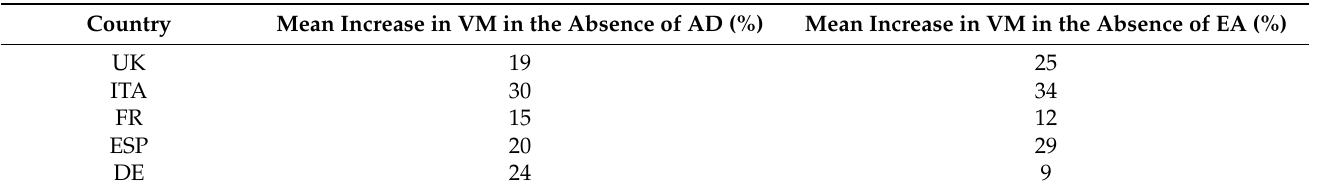
Table 2. Expert estimates of the absolute increase in A(H3N2) vaccine match in the absence of antigenic drift or egg adaptation changes, specific for each country, between 2014 and 2019.